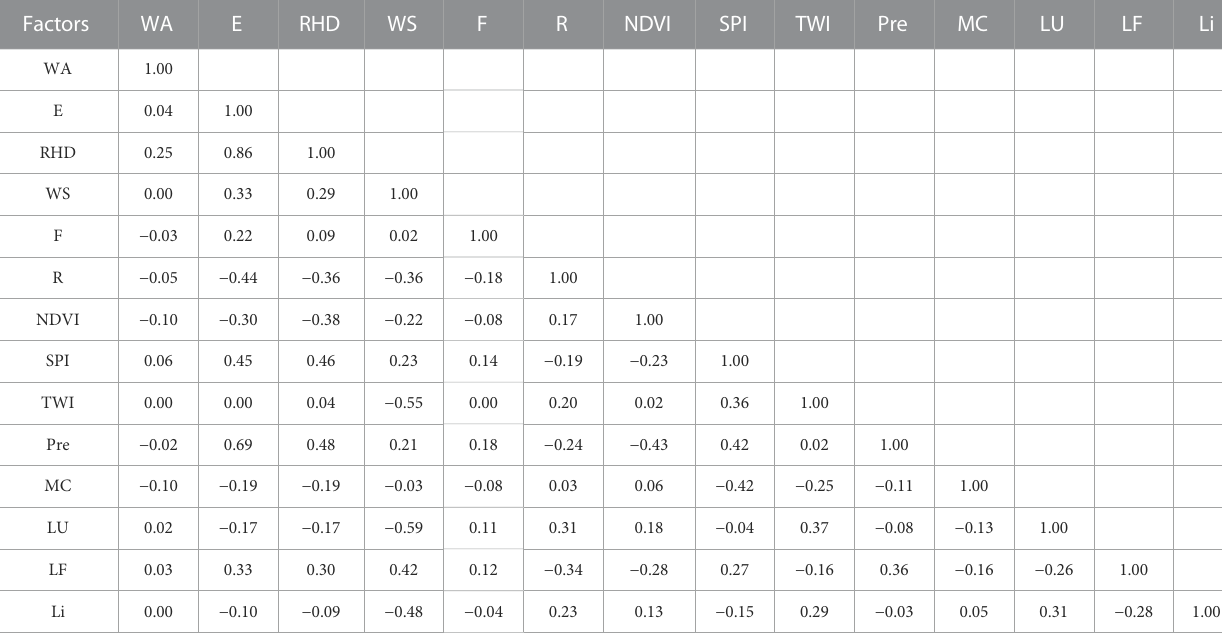
TABLE 1 The results of the Person ’ s Correlation Coef fi cient. Factors